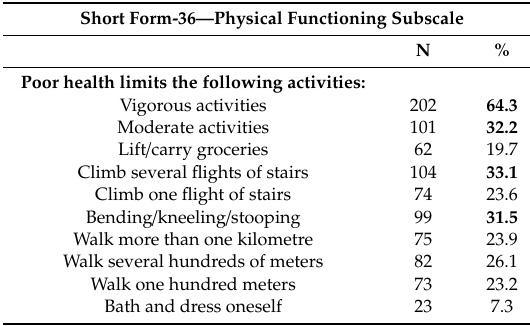
Table 5. Limitations in daily activities attributable to physical health problems among at-risk type 2 diabetes black and mixed-ancestry communities, Cape Town, 2018 (N = 316).